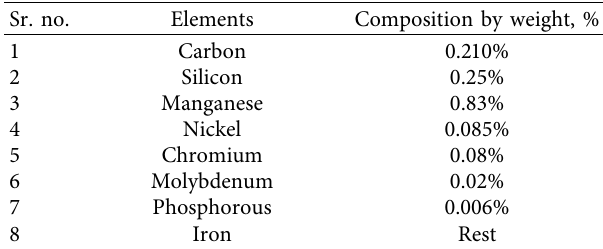
Table 2: Elements included (approximately in weight %) in 1020 steel